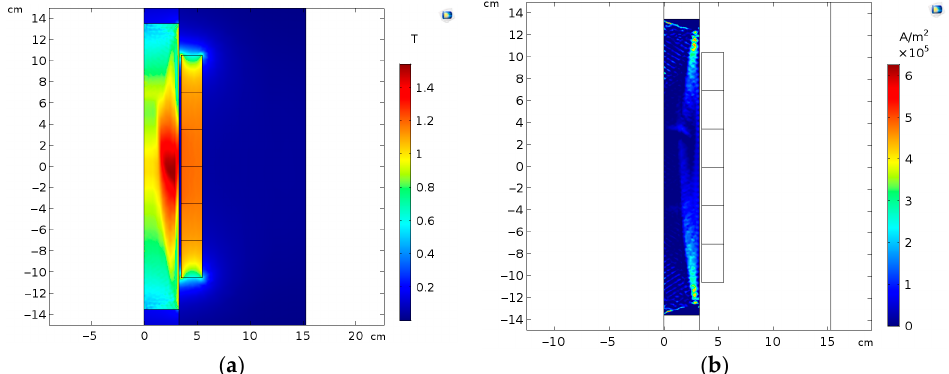
Figure 4. For Model I: ( a ) Magnetic flux density, ( b ) induced current density, at v = 1.0 m/s.